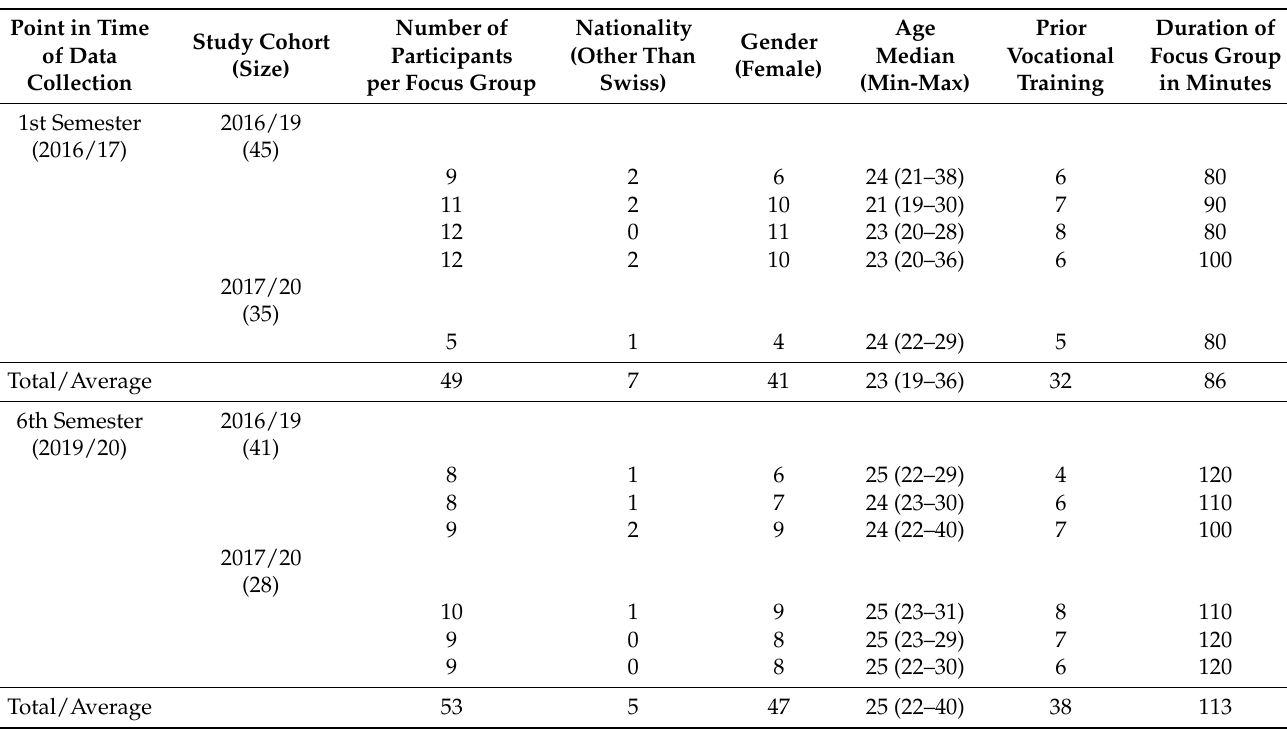
Table 1. Sociodemographic data of focus group